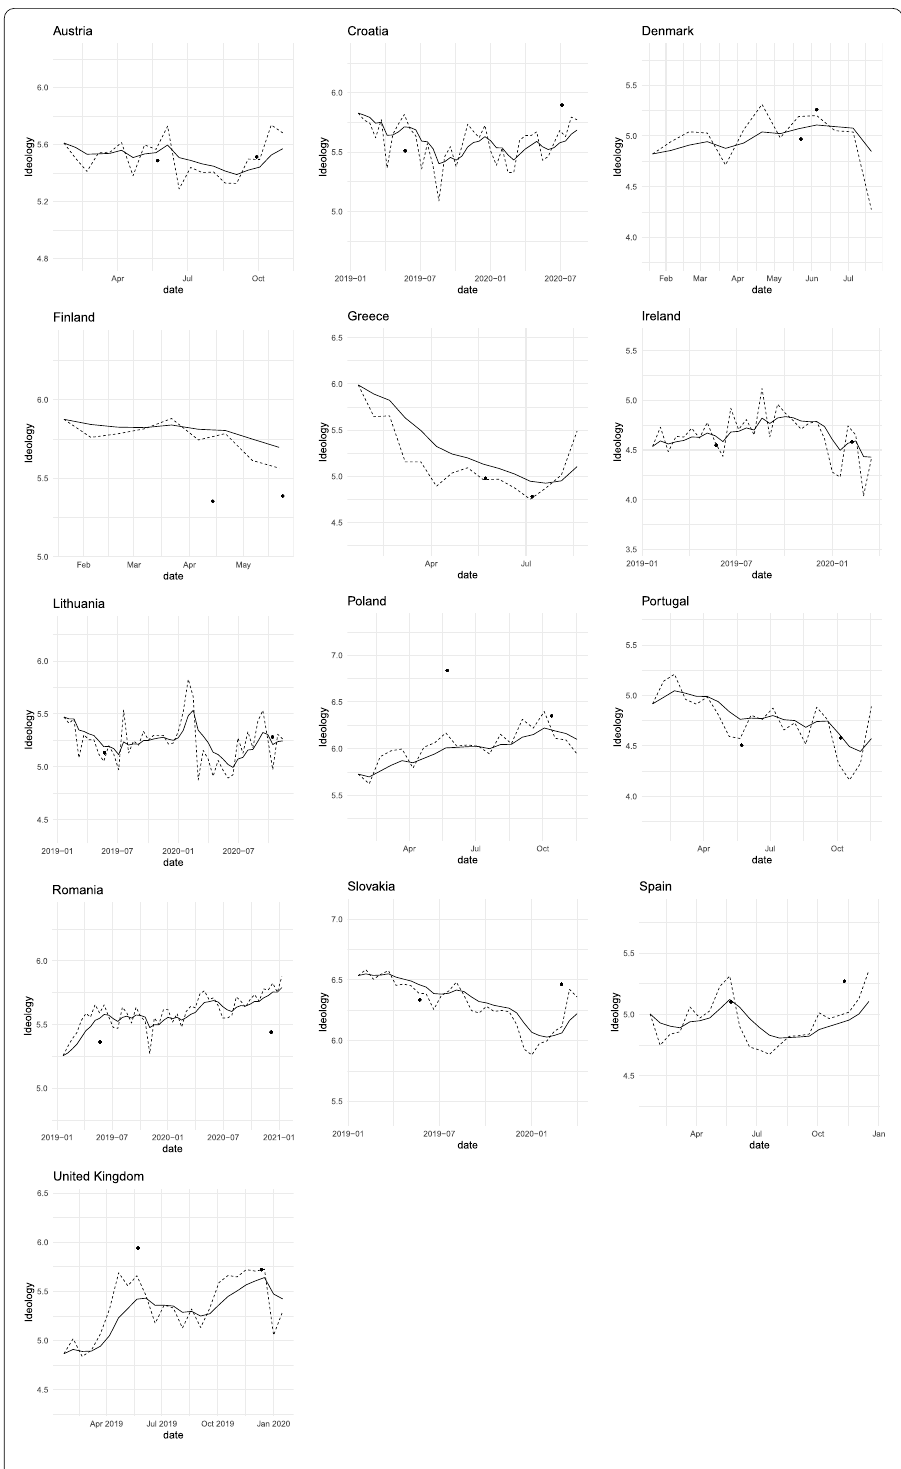
Figure 19 Ideology evolution in European